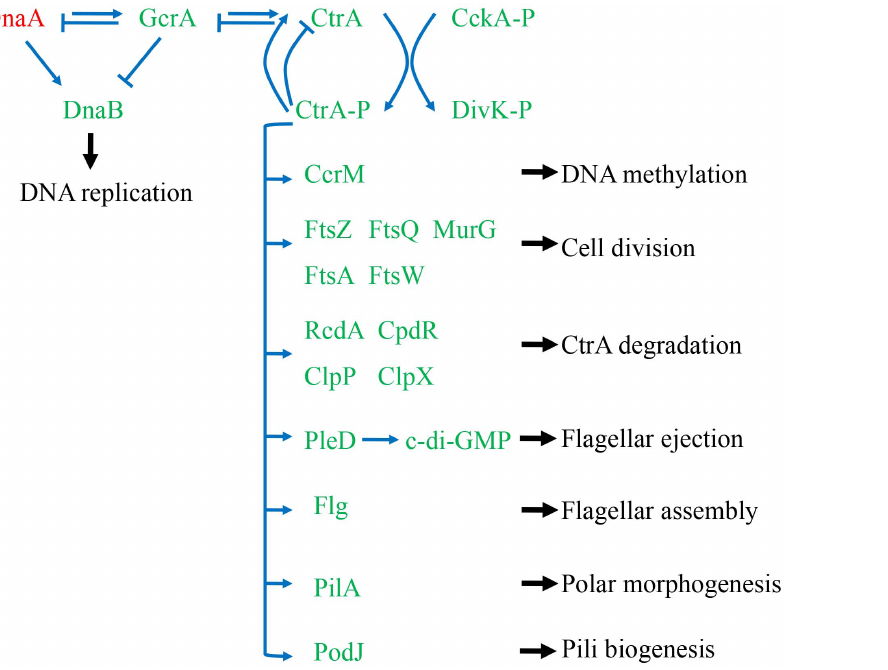
Figure 5. The putative CtrA regulatory network in M.huakuii 7653R according to the regulation model of cell cycle in C.crescentus . Blue arrows indicate positive effects and blunt blue lines indicate negative effects. Genes up-regulated were shown in red and down-regulated shown in green in M. huakuii 7653R bacteroids. Phosphorylated CtrA autoregulated its own transcription and CtrA regulated genes associated with DNA replication, DNA methylation, cell division, flagellar assembly, CtrA degradation, cell division, polar morphogenesis and pili